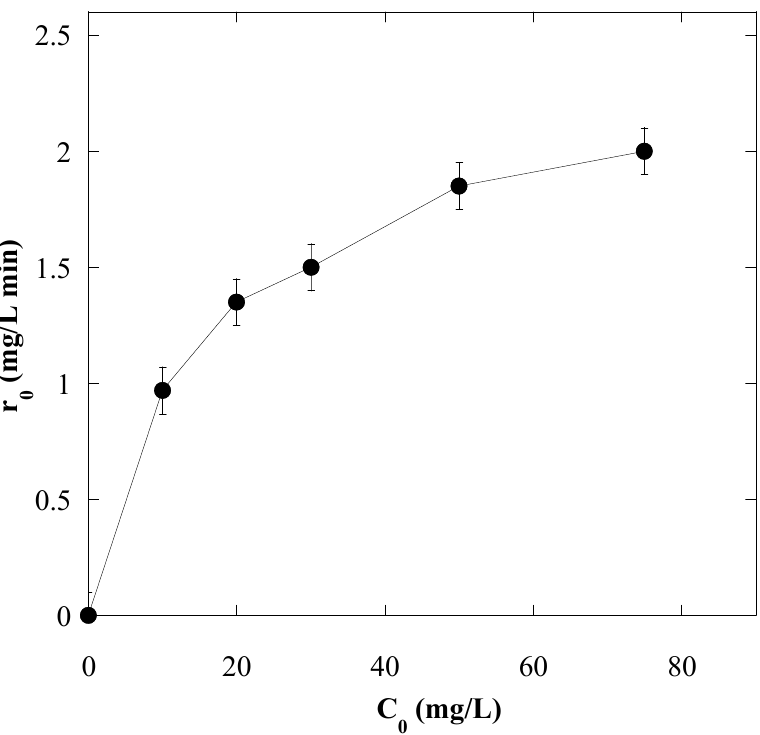
Figure 8. Initial AO10 degradation rate (r 0 ) vs. its initial concentration C 0 , under the same conditions of Figure 8.